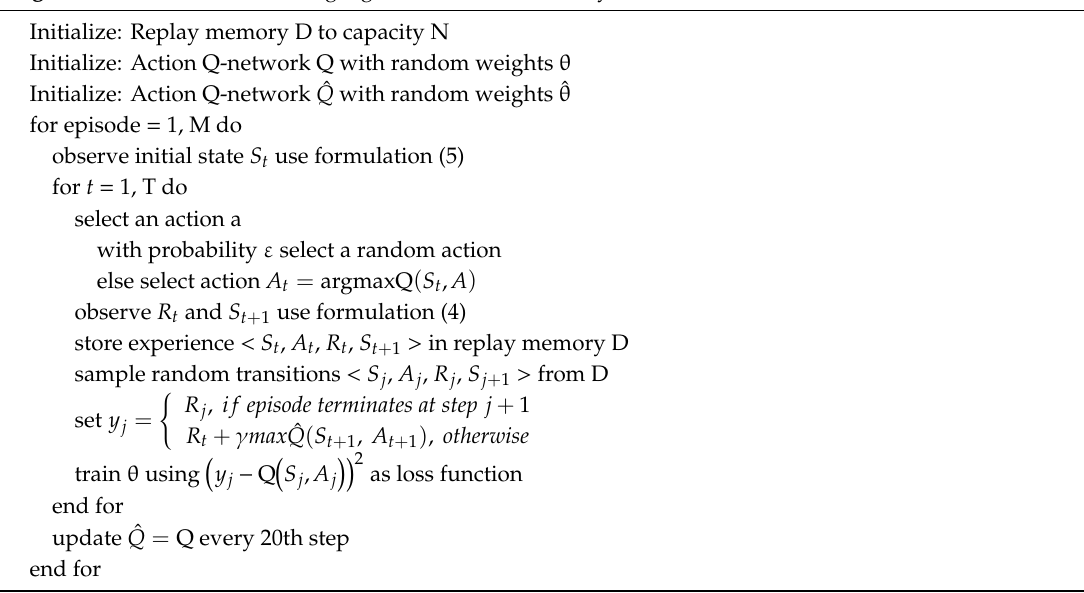
Algorithm 1. Q-network training algorithm for a similar